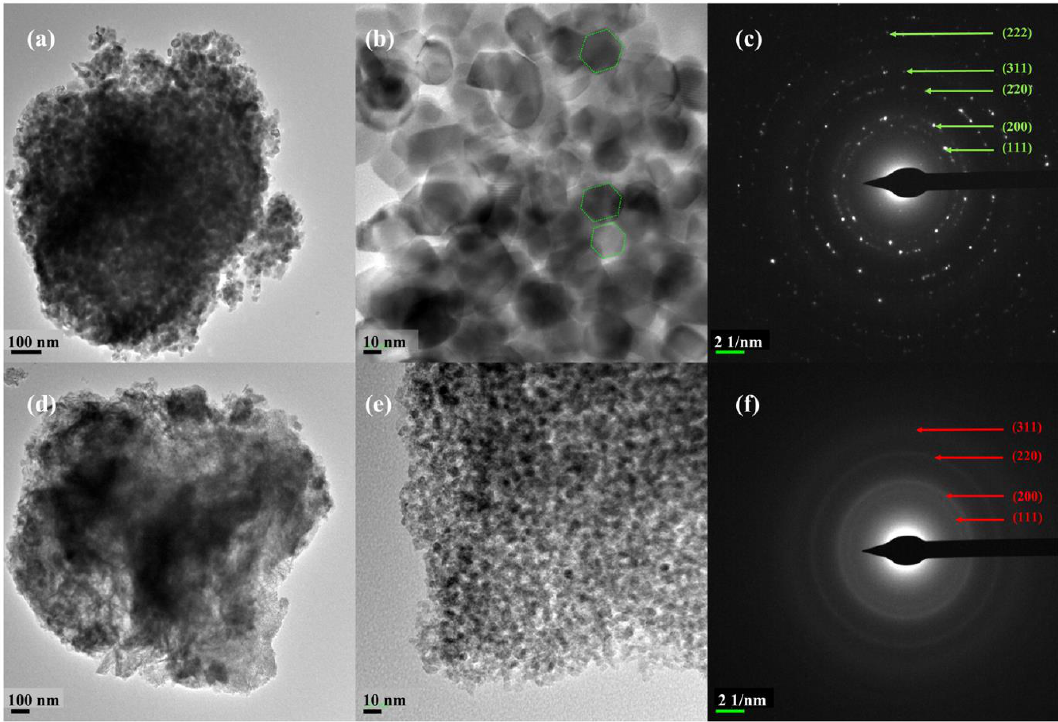
Figure 3. TEM images of N ( a , b ), NM10 ( d , e ), and electron diffraction pattern of N ( c ) and NM10 ( f ).